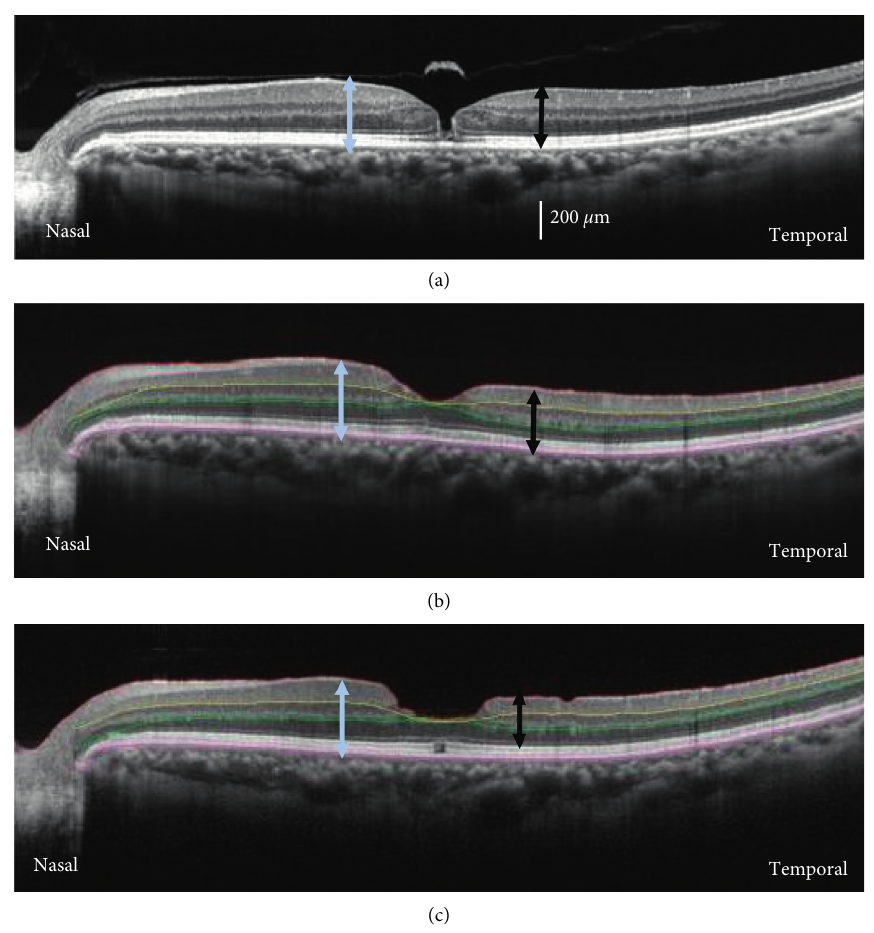
Figure 2: Representative cross-sectional SD-OCT images obtained by horizontal scans from eyes with a MH preoperatively (baseline, (a)) and postoperatively at the 0.5 (b) and 24 (c) months. The arrows placed at 1.0mm from the fovea indicate the total retinal thickness in the nasal (gray arrows) and temporal (black arrows) retina. SD-OCT, spectral-domain optical coherence tomography; MH, macular